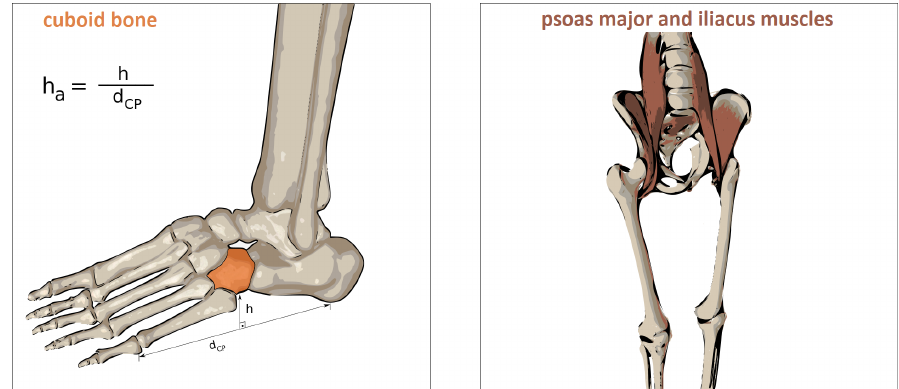
Figure 3. Left cuboid bone to model the arch of the foot using the relative height h a ( left ) and muscles responsible for hip flexion, i.e., psoas major and iliacus muscles ( right